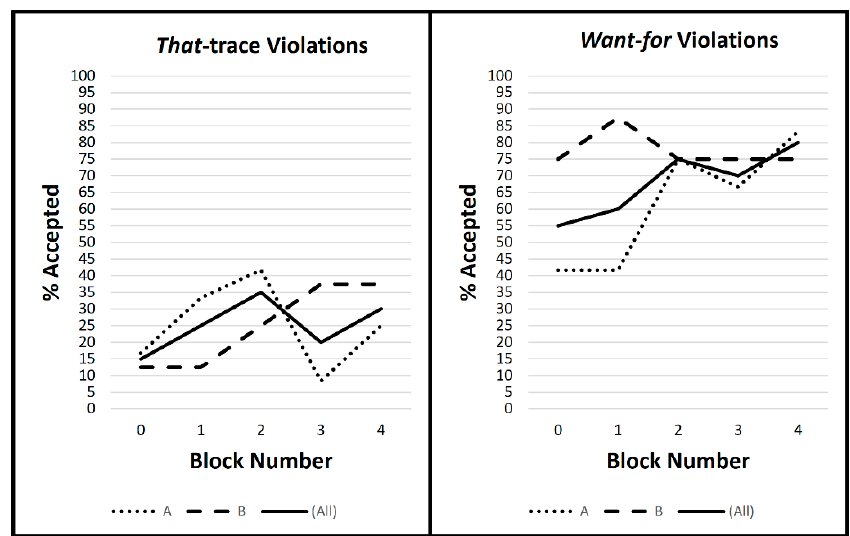
Figure 4. Experiment I, That -trace and Want-for violations.